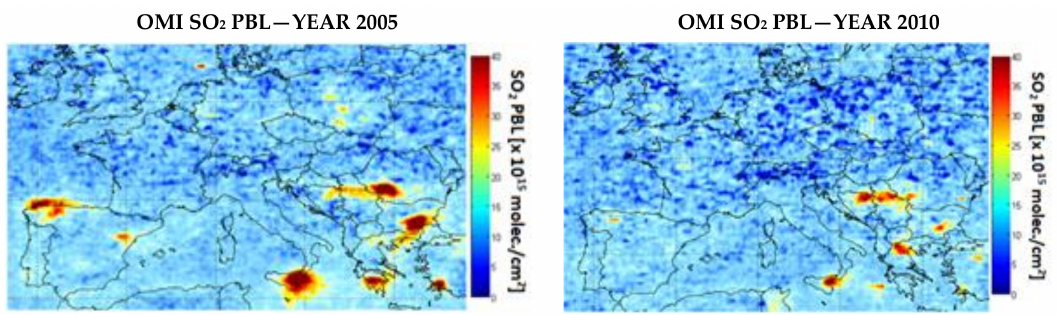
Figure 3. Annual tropospheric NO 2 VCD based on OMI observations for 2005 vs. 2010.